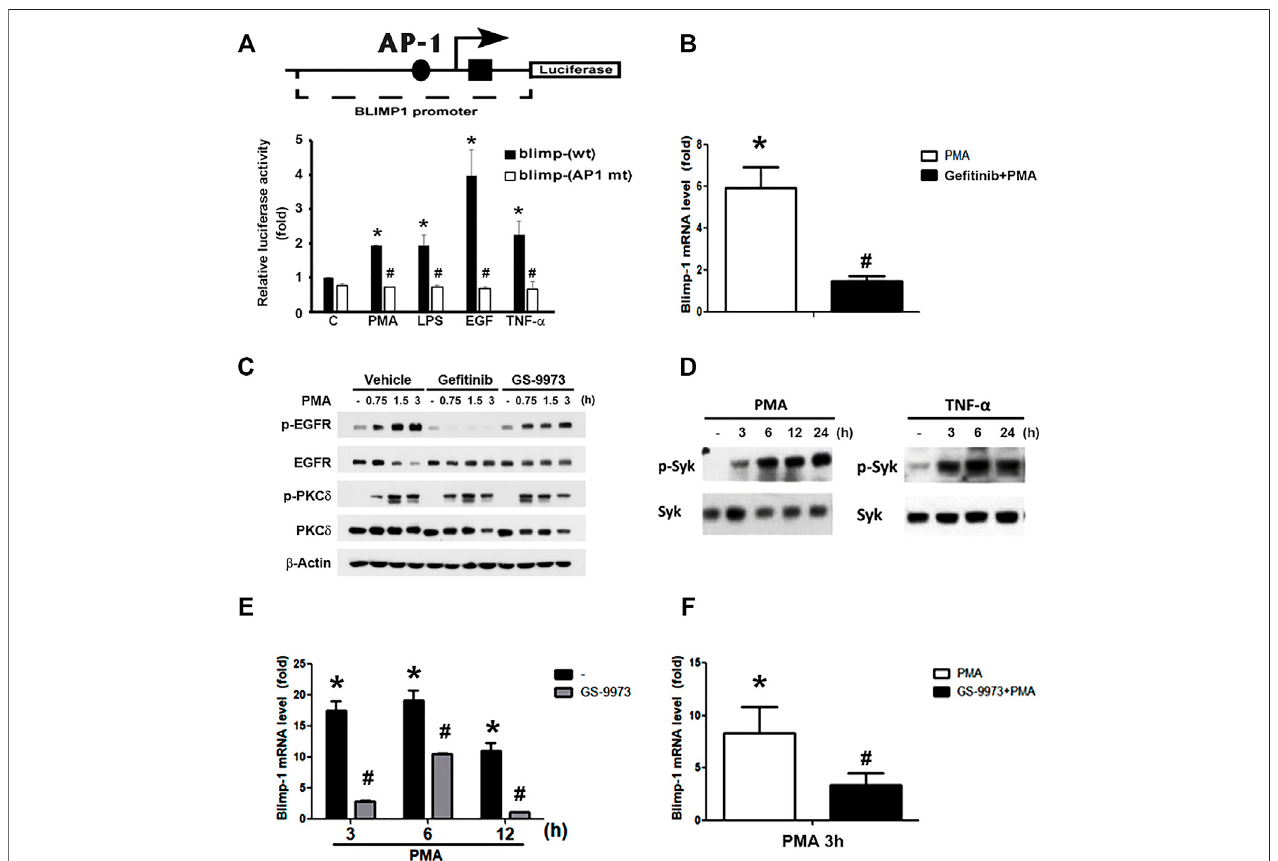
FIGURE 3 | Roles of EGFR and Syk activation in PMA- and TNF- α -induced Blimp-1 gene expression. (A) The indicated luciferase constructs in lentiviral vectors were transiently transfected in HaCaT cells and then PMA (30 nM), LPS (1 μ g/ml), EGF (50 ng/ml), and TNF- α (10 ng/ml) was treated for 15 h. After harvesting, the luciferase luminescence was measured. Bars showed means ± S.E.M. ( n = 3). * p < 0.05 as compared to control group. # p < 0.05, indicating the abolishment of agent- induced luciferase activity by AP-1 deletion. (B) After pretreatment with ge fi tinib (1 uM) for 30 min, Cal-27 cells were treated with PMA (30 nM) for 3 h, and then mRNA level of Blimp-1 was evaluated by Q-PCR. (C) HaCaT cells were pre-treated with ge fi tinib (1 uM) or GS-9973 (1 uM) for 30 min prior to the stimulation with PMA (30 nM). HaCaT cells (D,E) and Cal-27 cells (F) were stimulated with PMA (30 nM) or TNF- α (10 ng/ml) for indicated time periods, and in some experiments GS-9973 (1 μ M) was pre-treated for 30 min (E,F) . EGFR, PKC δ and Syk were analyzed by immunoblotting (C,D) , and Q-PCR was performed to evaluate the mRNA levels of Blimp-1 (E,F) . * p < 0.05 (mean ± S.E.M., n = 3), as compared to control group. # p < 0.05, indicating the signi fi cant inhibitory effects of AP-1 mutation, ge fi tinib and GS- 9973 on Blimp-1 gene